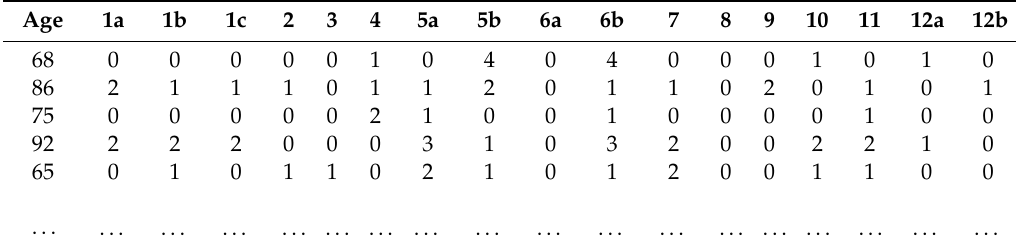
Table 8. An example of the NIHSS